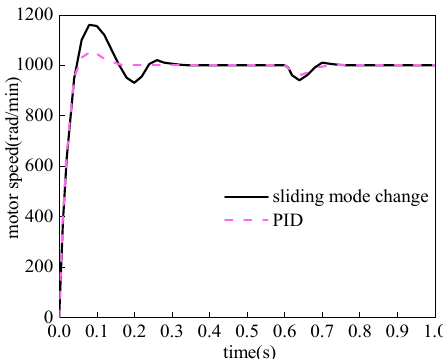
Figure 7. Motor speed simulation.